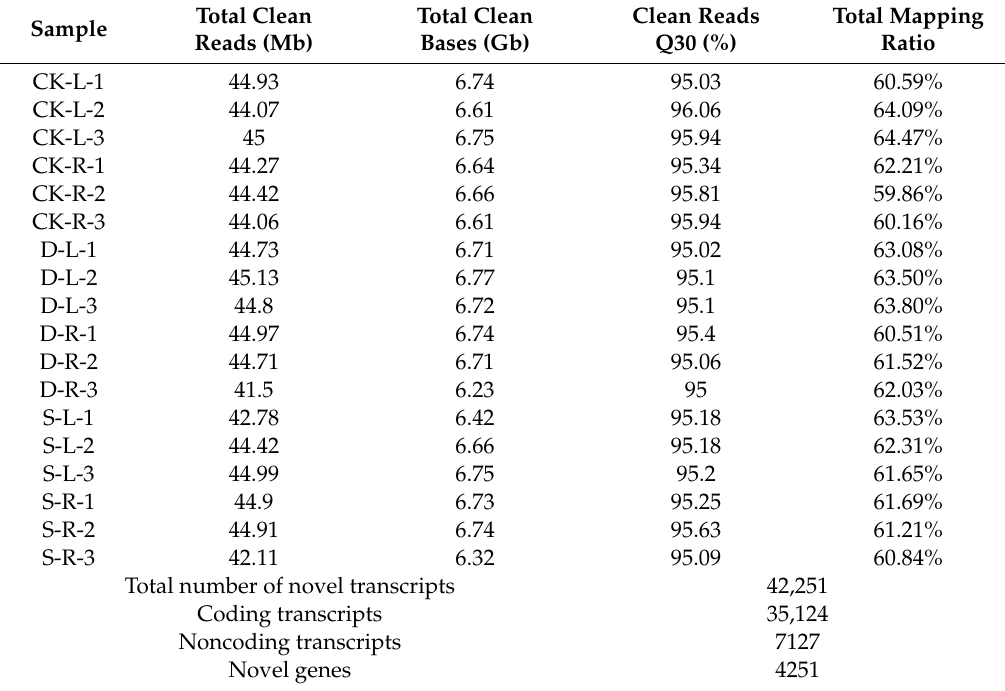
Table 1. Summary of sequencing reads after filtering and genome